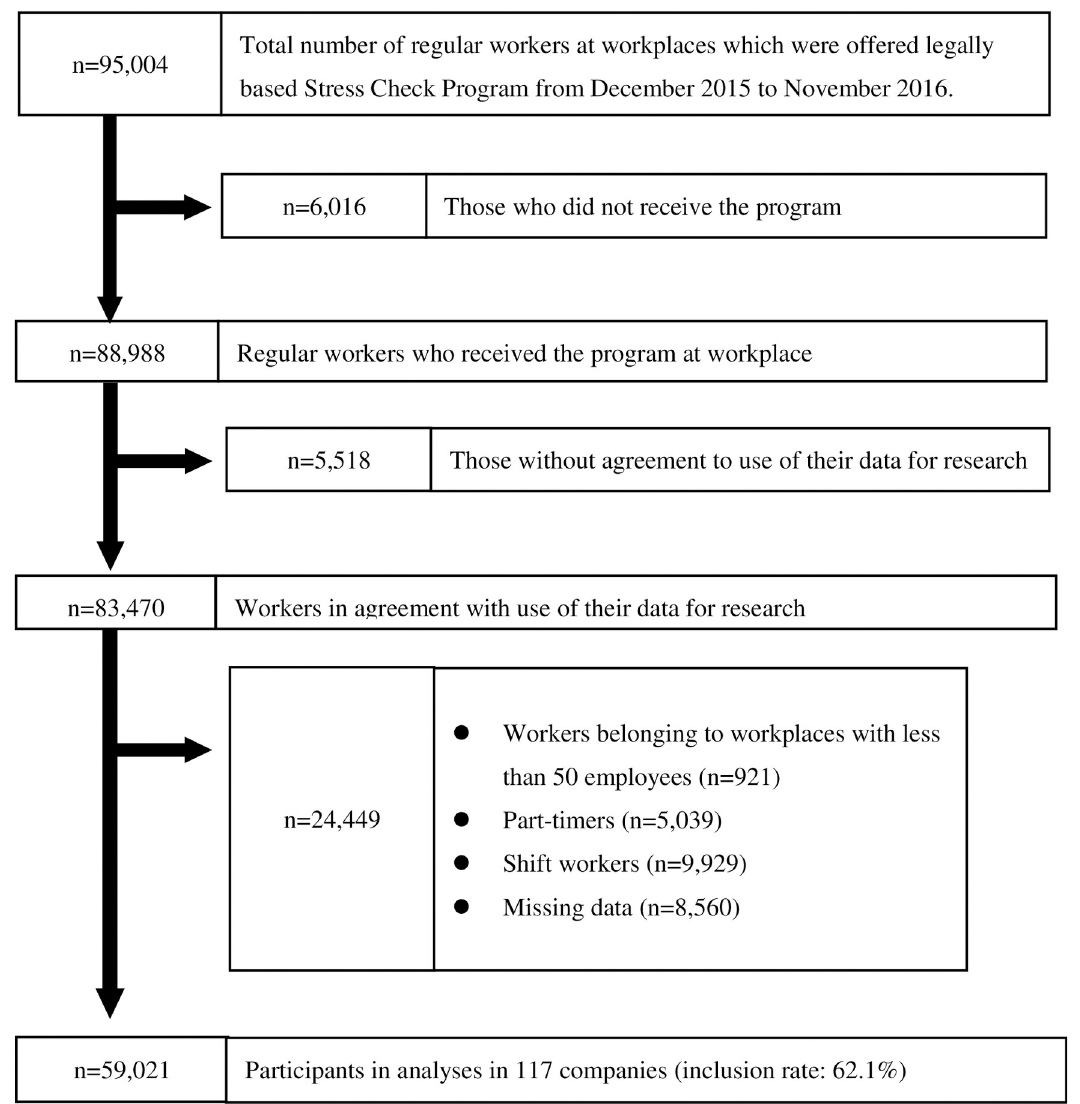
Fig 1. Flow chart of study